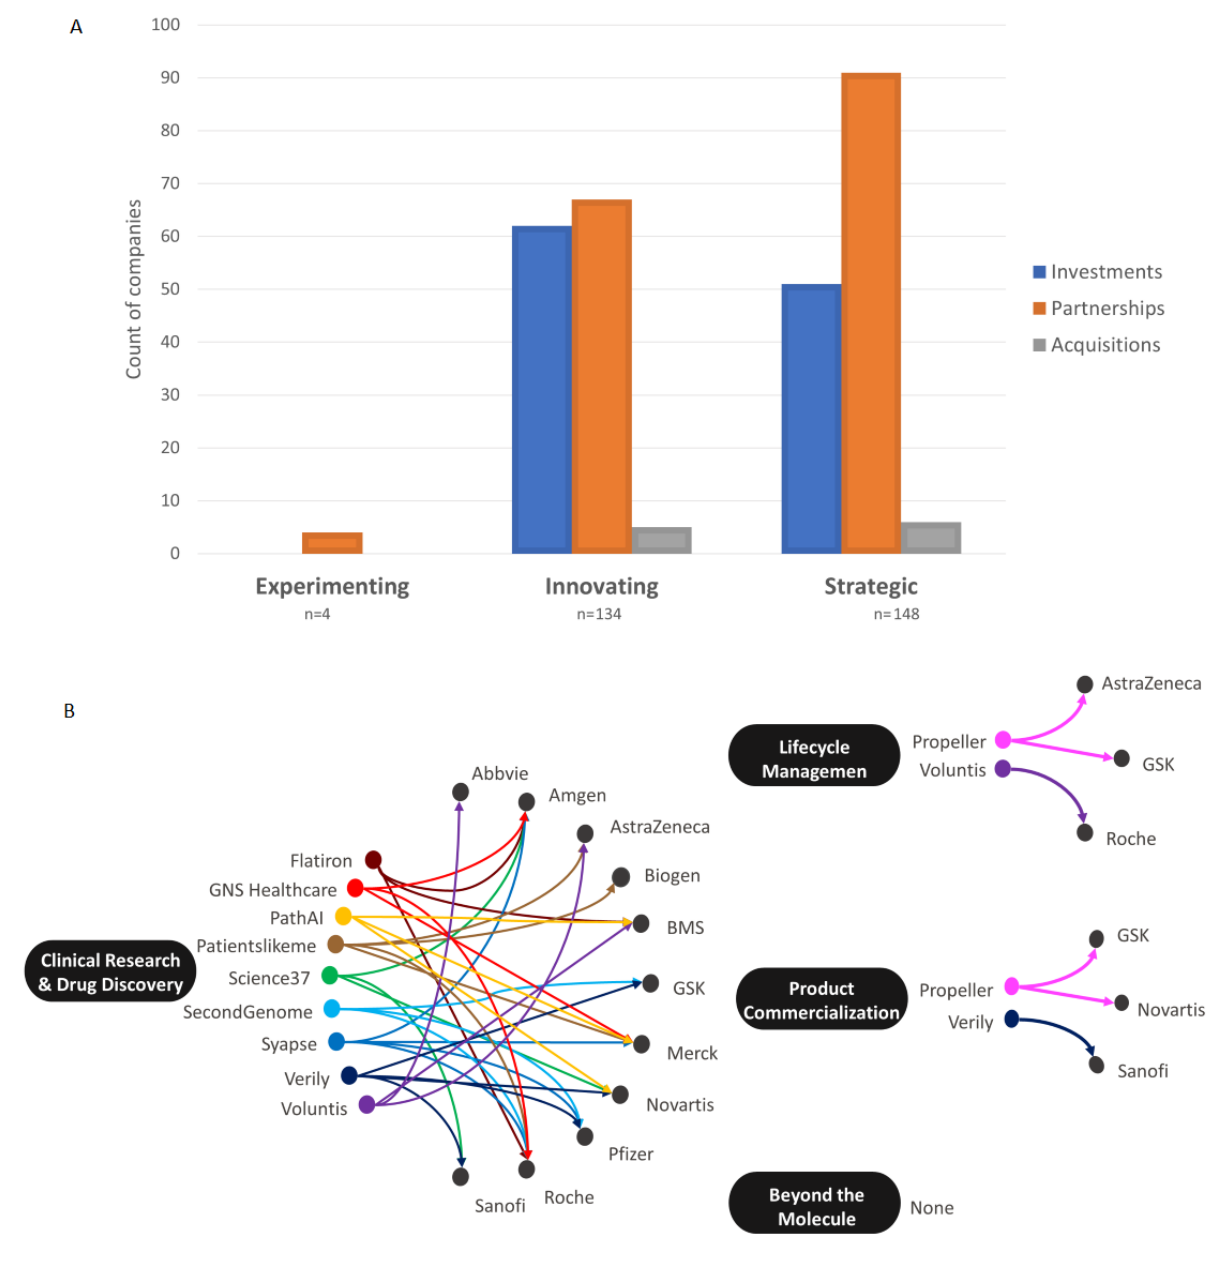
Figure 2. (A) Distribution of biopharma’s digital health partnerships, investments, and acquisitions from 2010 to 2020. Investments included direct investments from biopharma or a subsidiary arm of the parent company. Partnerships are the preferred format for achieving digital health maturity. (B) Digital health companies with at least three different biopharma interactions (eg, investment, partnership, and acquisition) were plotted against the four digital health segments. Currently, clinical research and drug discovery digital health companies encapsulate the largest segment of investments or partnerships from biopharma. None: the analysis did not return any digital health companies focusing on the beyond the molecule segment, which met the minimum criteria of at least three different biopharma